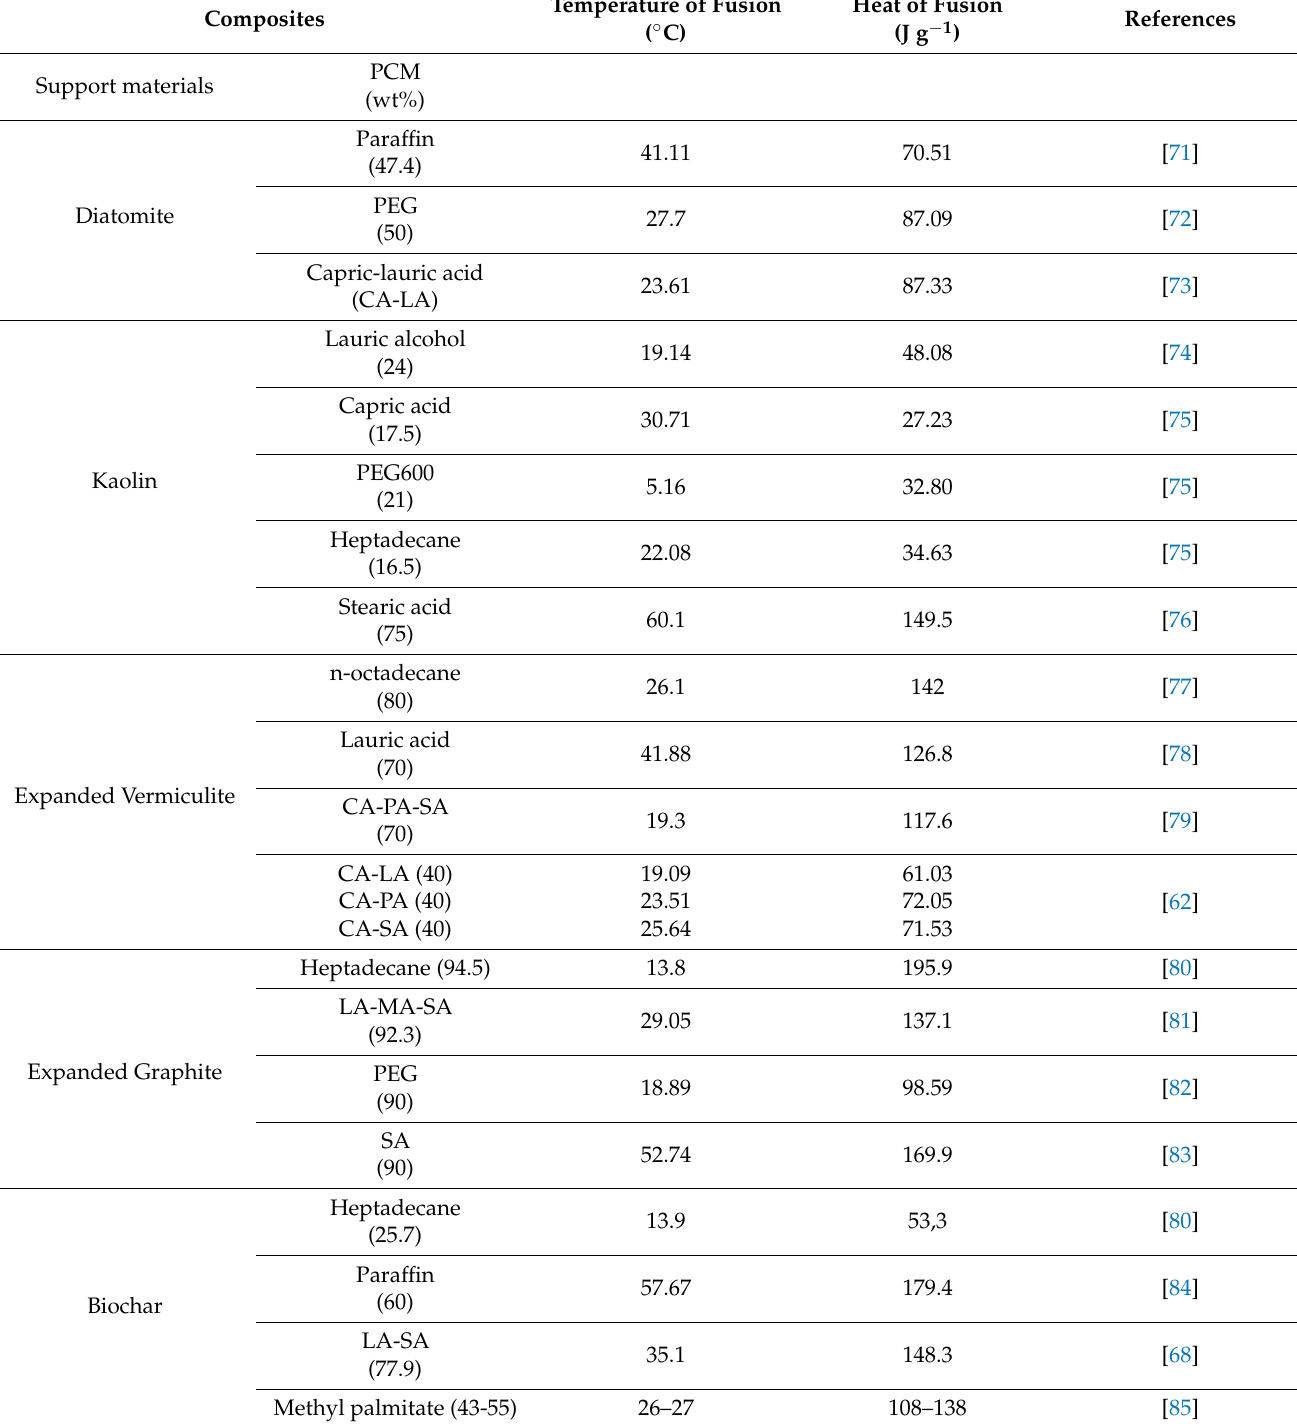
Table 4. Various experimental studies using naturally occurring support materials for the fabrication of shape-stabilized